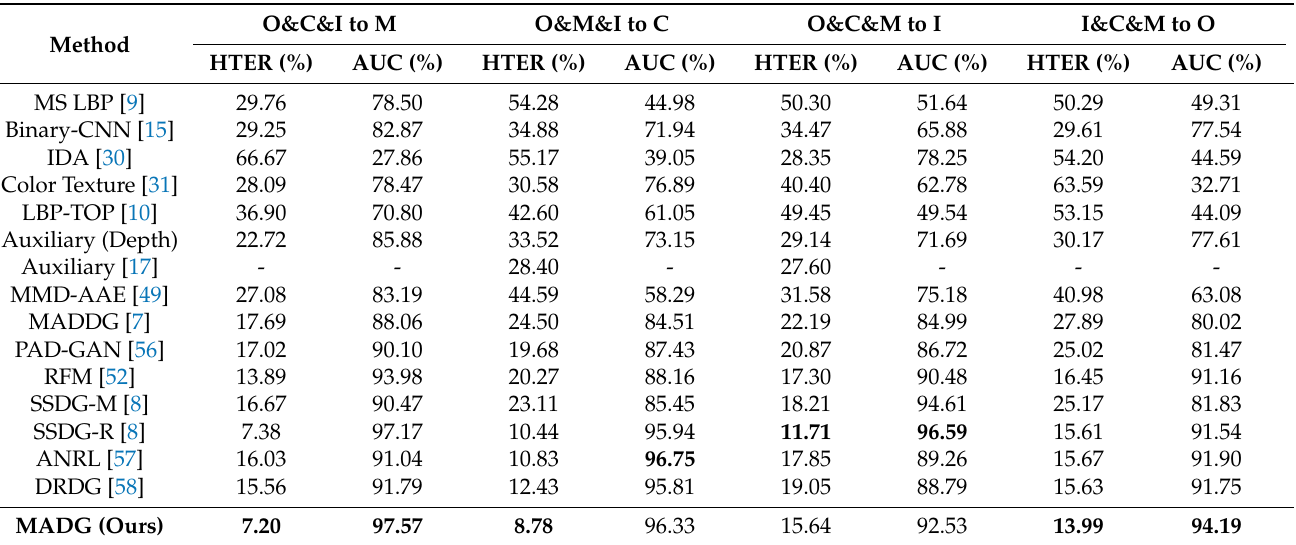
Table 8. Comparison with state-of-the-art methods. The header is the task protocol and the bold represents the optimal